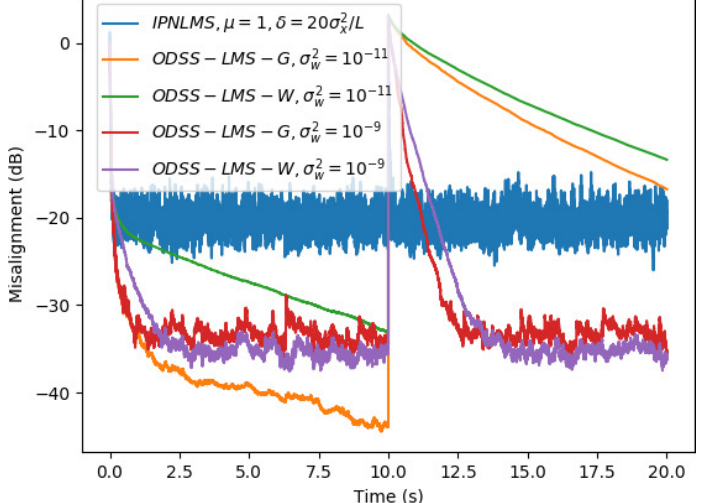
Figure 6. Normalized misalignment of the IPNLMS, ODSS-LMS-G, and ODSS-LMS-W algorithms for different values of σ 2 w . Echo path changes at time 10 s. The input signal is an AR(1) process, with β = 0.8, L = 512, and SNR = 20 dB. The unknown system is the network echo path.